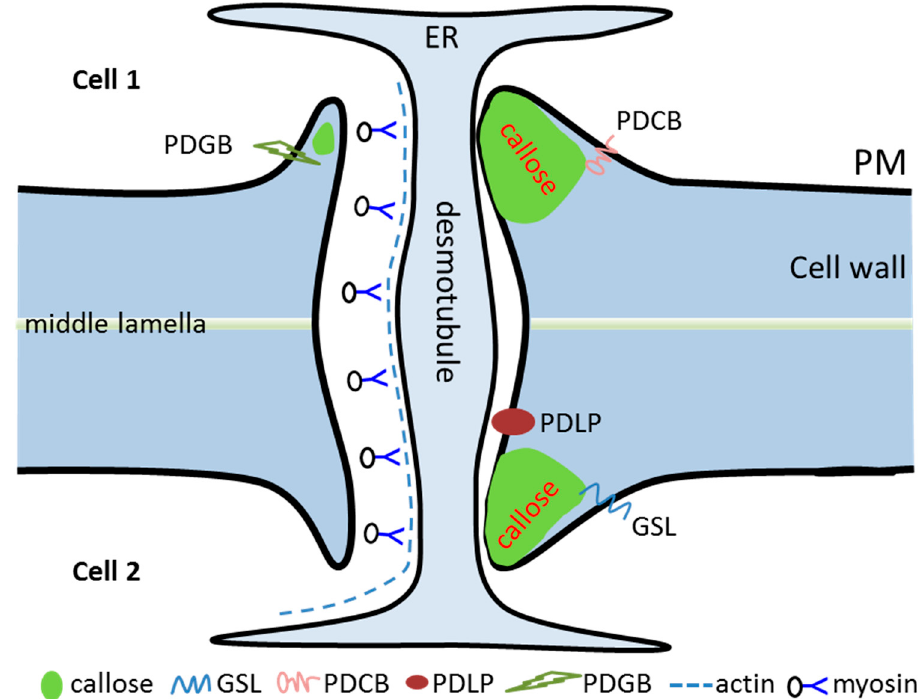
Figure 1. A simplified schematic representation of plasmodesmata (PD) structural and functional proteins. Permeability of PD in the plant cell wall is controlled by dynamic callose deposition (closed, right side) and degradation (open, left side) at the neck region of PD. ER, endoplasmic reticulum; GSL, glucan synthase-like; PM, plasma membrane; PDCB, PD-associated callose binding protein; PDGB, plasmodesmal associated β -1,3-glucanase; PDLP, PD-localized